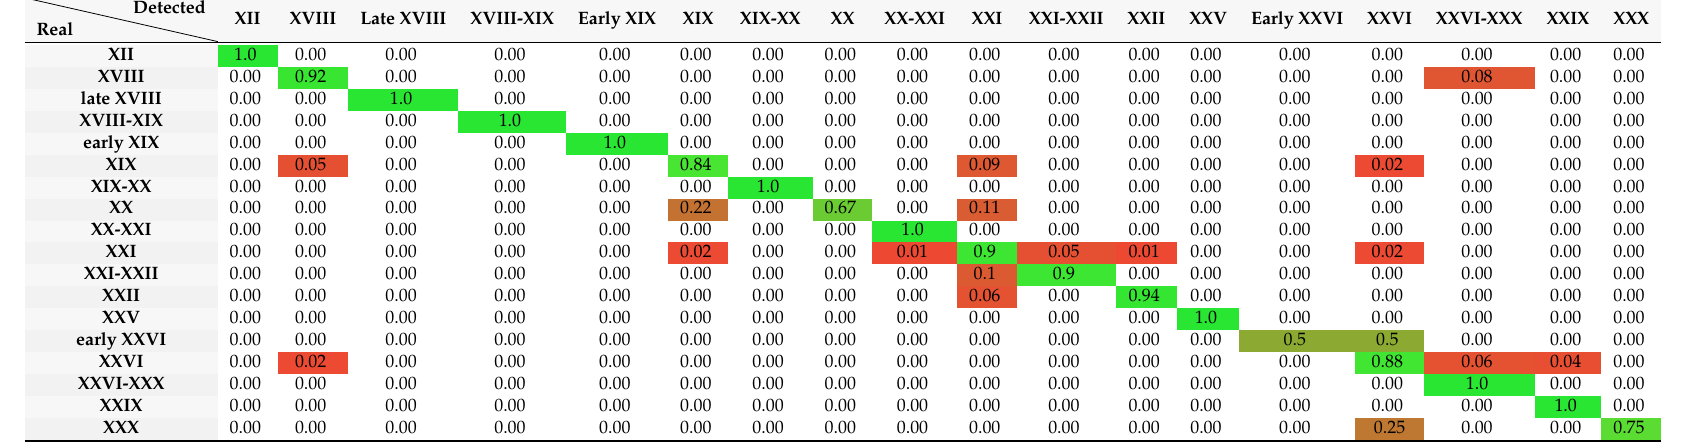
Table 4. Confusion matrix of the dynasty detection of the FN + HN model (%). The green cells represent success in the dynasty detection. The redder the cells are, the bigger error in the dynasty